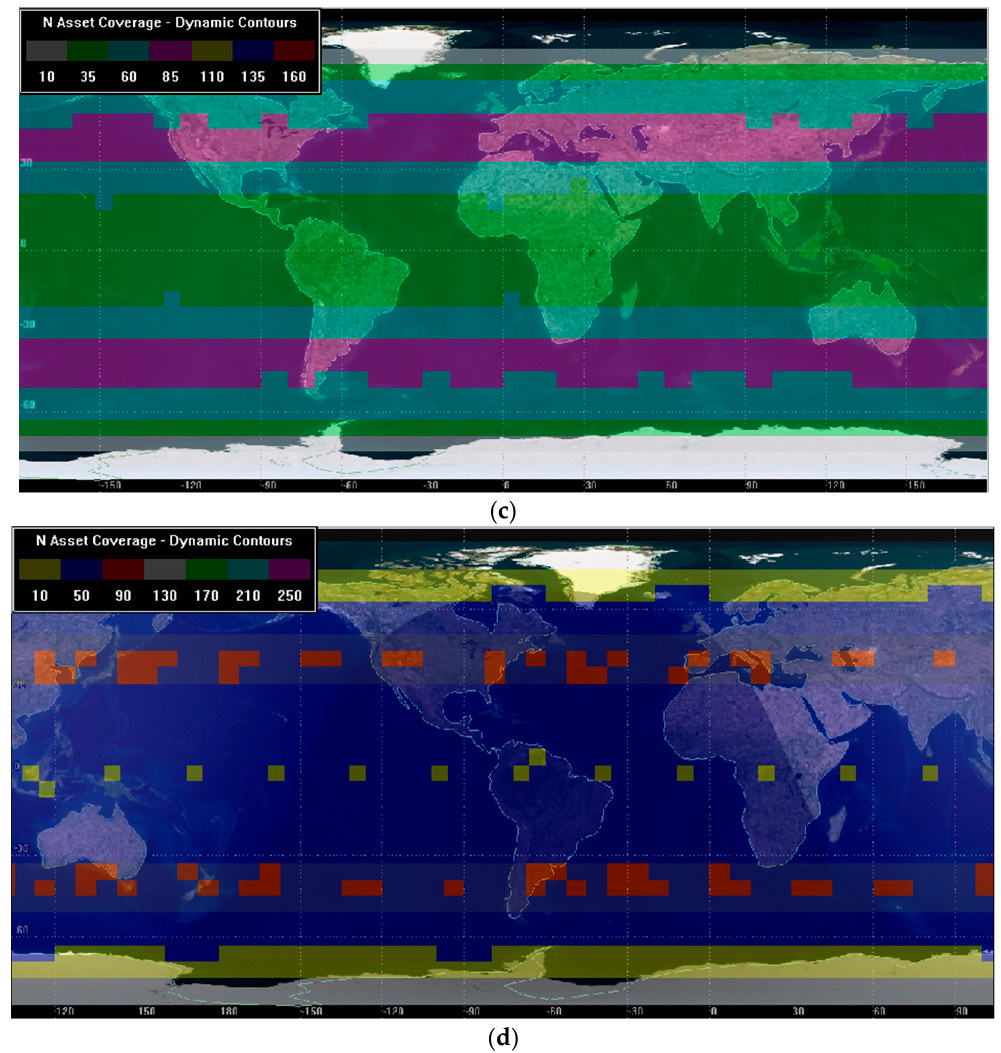
Figure 8. Comparison of coverage performance of Starlink and OneWeb constellation under different F. ( a ) OneWeb constellation, F = 1; ( b ) OneWeb constellation, F = 9; ( c ) Starlink constellation, F = 1; ( d ) Starlink constellation, F = 11.